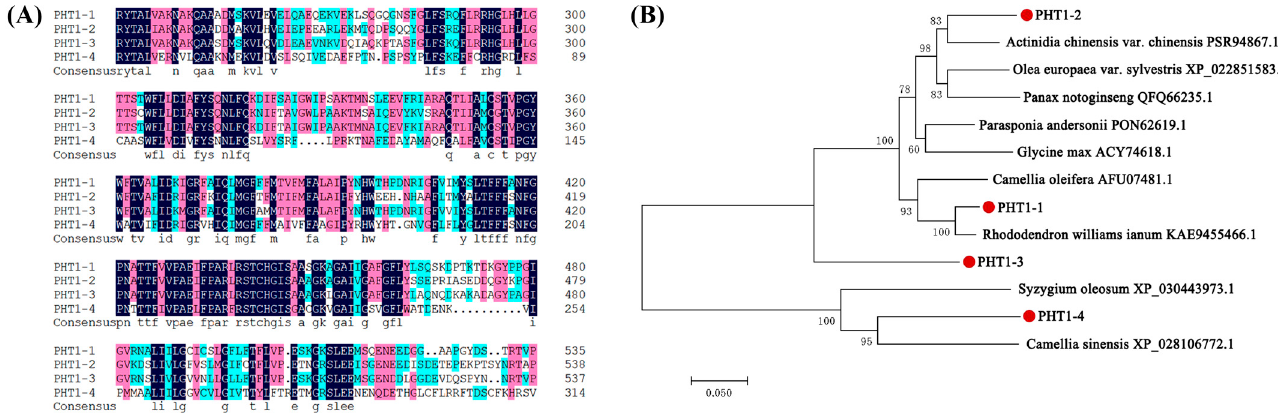
Figure 6. Multiple alignments of amino acid sequences ( A ) and phylogenetic tree ( B ) of the PHT1 protein family. Identical amino acid residues are shaded in black and similar residues in color. Phylogenetic analysis was performed by the MEGA software (version 7.0) using the neighbor-joining algorithm. Numbers in the figure represent bootstrap values (1000 replicates).